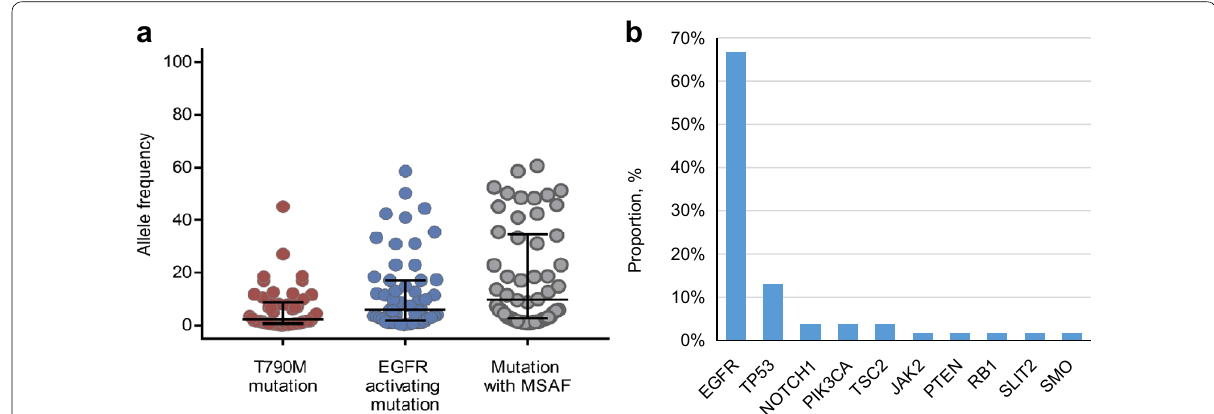
Fig. 1 Maximum somatic allele frequency (MSAF). a Allele frequency of T790M mutation, EGFR activating mutation, and maximum somatic mutation in 54 patients. AFs were corrected with their copy numbers. b Distribution of the genes with maximum allele frequency among 54 patients. AFs were corrected with their copy numbers